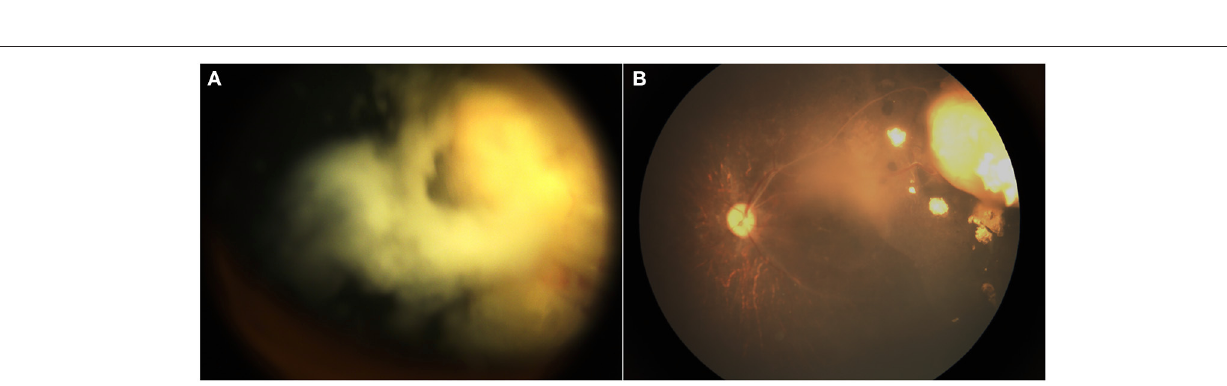
FIGURE 3 | A 12-month-old boy with group D retinoblastoma presented with a peripheral retinal tumor and diffuse vitreous seeds. The regression of tumor and seeds was noted at the 18-month follow-up. Before (A) and after (B) 3 cycles of primary IAC infusion combined with intravitreal chemotherapy.